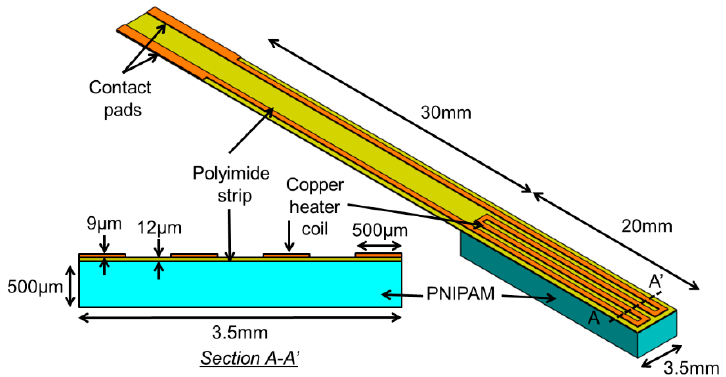
Figure 2. Device design showing the flexible active strip integrated with a poly( N -isopropylacrylamide) (PNIPAM) hydrogel layer and a micropatterned planar heater at the free end of the strip.